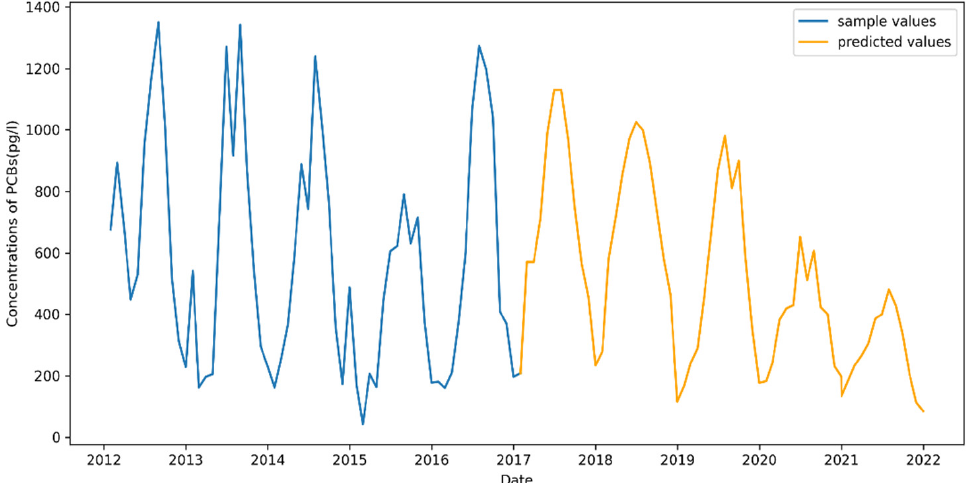
Figure 10. The predicted concentration values of PCBs at Chicago in the next 5